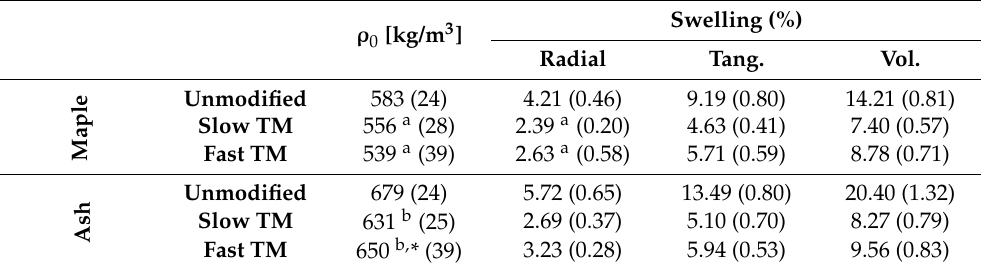
Table 3. Oven-dry density and swelling of unmodified and TM maple and ash